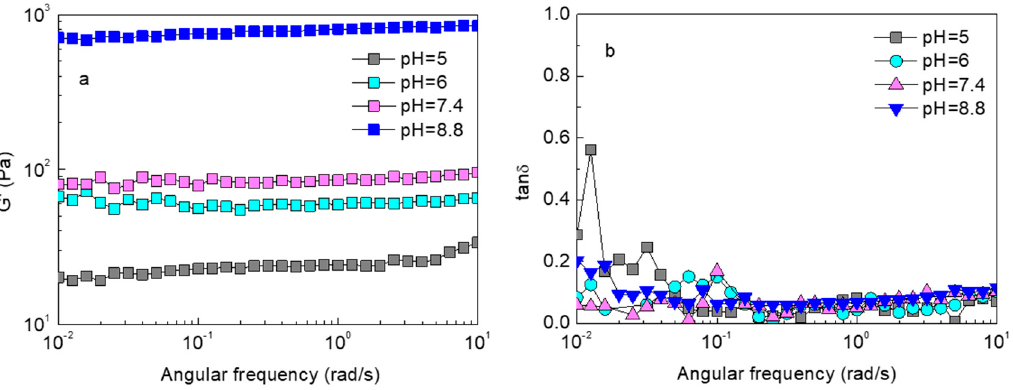
Figure 4. Angular frequency dependence of G’ ( a ) and tan δ ( b ) at various pHs of PAA-g-P(boc-LL) aqueous solutions of C p = 0.5